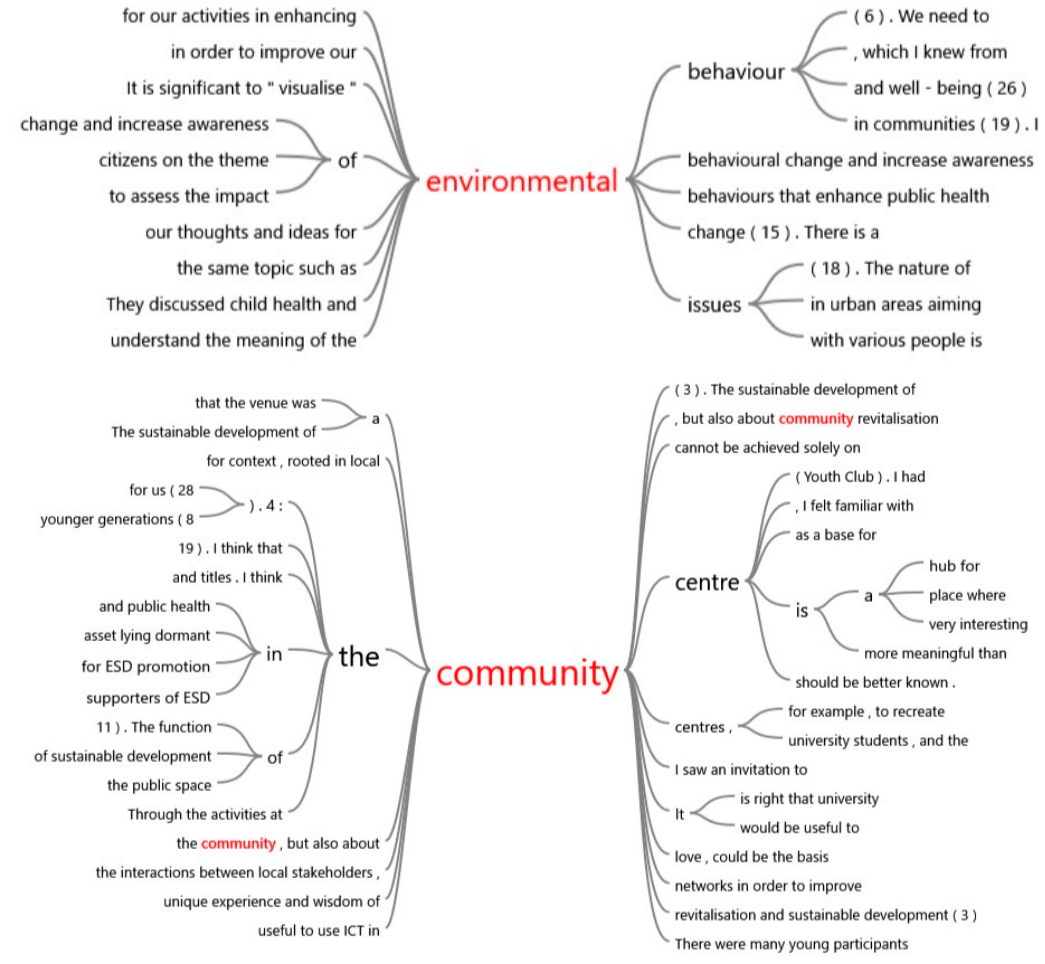
Figure 7. Word tree for ’environment’ and ‘community’.